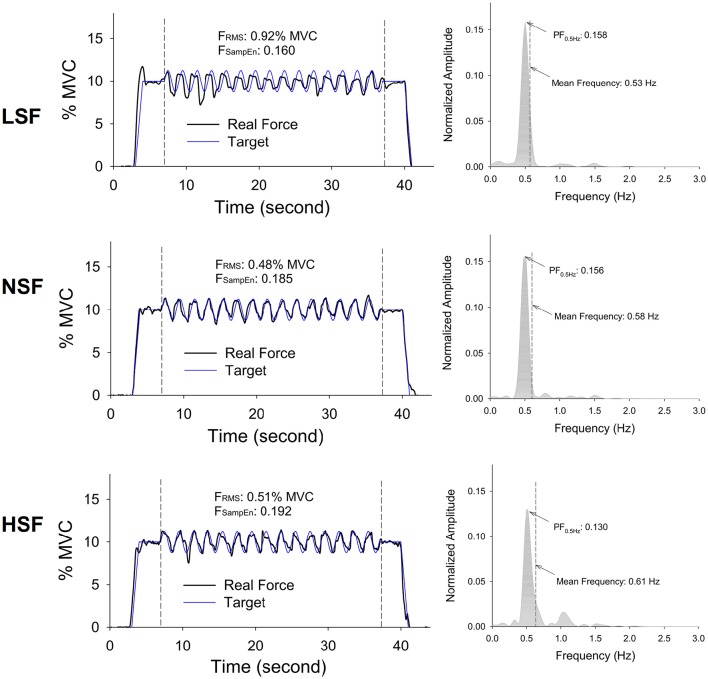
Representative trials and pooled power spectra of force data of the times of interest from a typical participant for the low scaling factor (LSF), normal scaling factor (NSF), and high scaling factor (HSF) conditions. The mean frequency of each pooled spectrum of force output is labeled. (FRMS: root mean square value of force output, FSampEn: Sample entropy of force output, PF0.5Hz: normalized amplitude of peak frequency at 0.5 Hz).